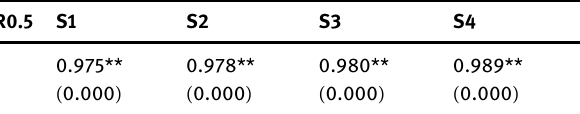
Table 2: Spearman ’ s correlation coe ffi cients and p values for 0.5 cm thick bolus samples comparison ( p values in parenthesis